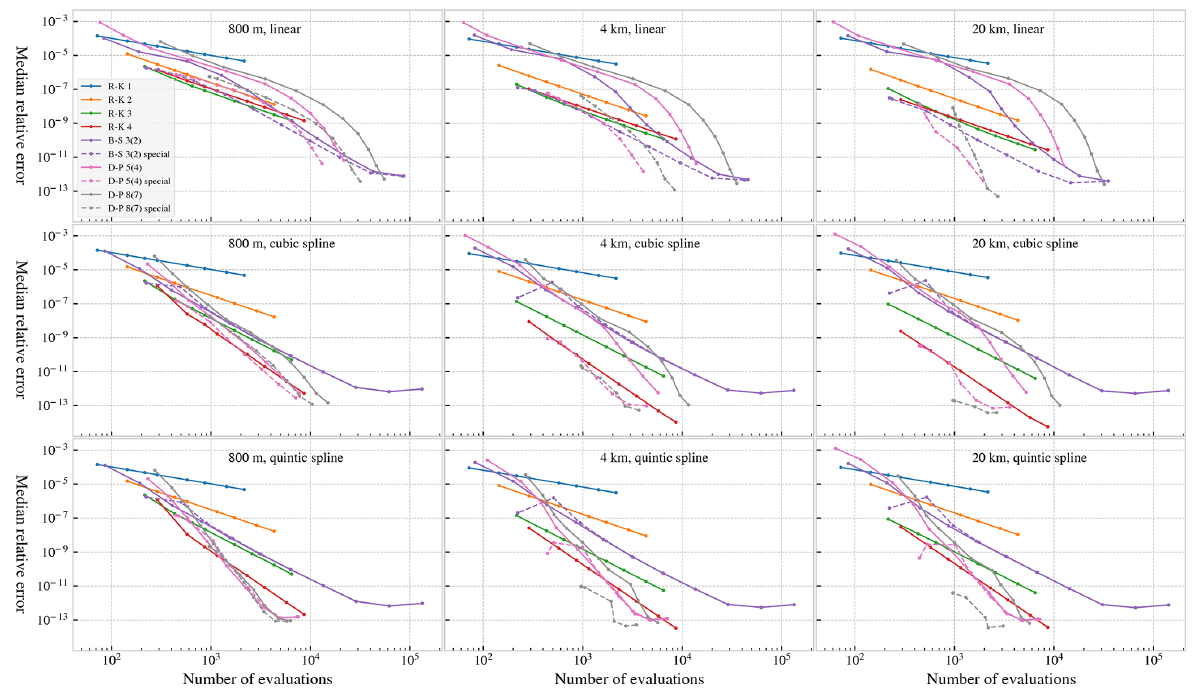
Figure 5. Relative global error (relative to the reference solution) as a function of number of evaluations of the right-hand side. Note that the special-purpose integrators are (by design) unable to make longer steps than the interval on which the data are provided. This means some of the simulations with higher tolerance (allowing larger errors) have in practice defaulted to fixed-step simulation with a time step of 3600s, making several of the data points identical. This is most readily observed for the special-purpose Dormand–Prince 8(7) integrator in the lower-right